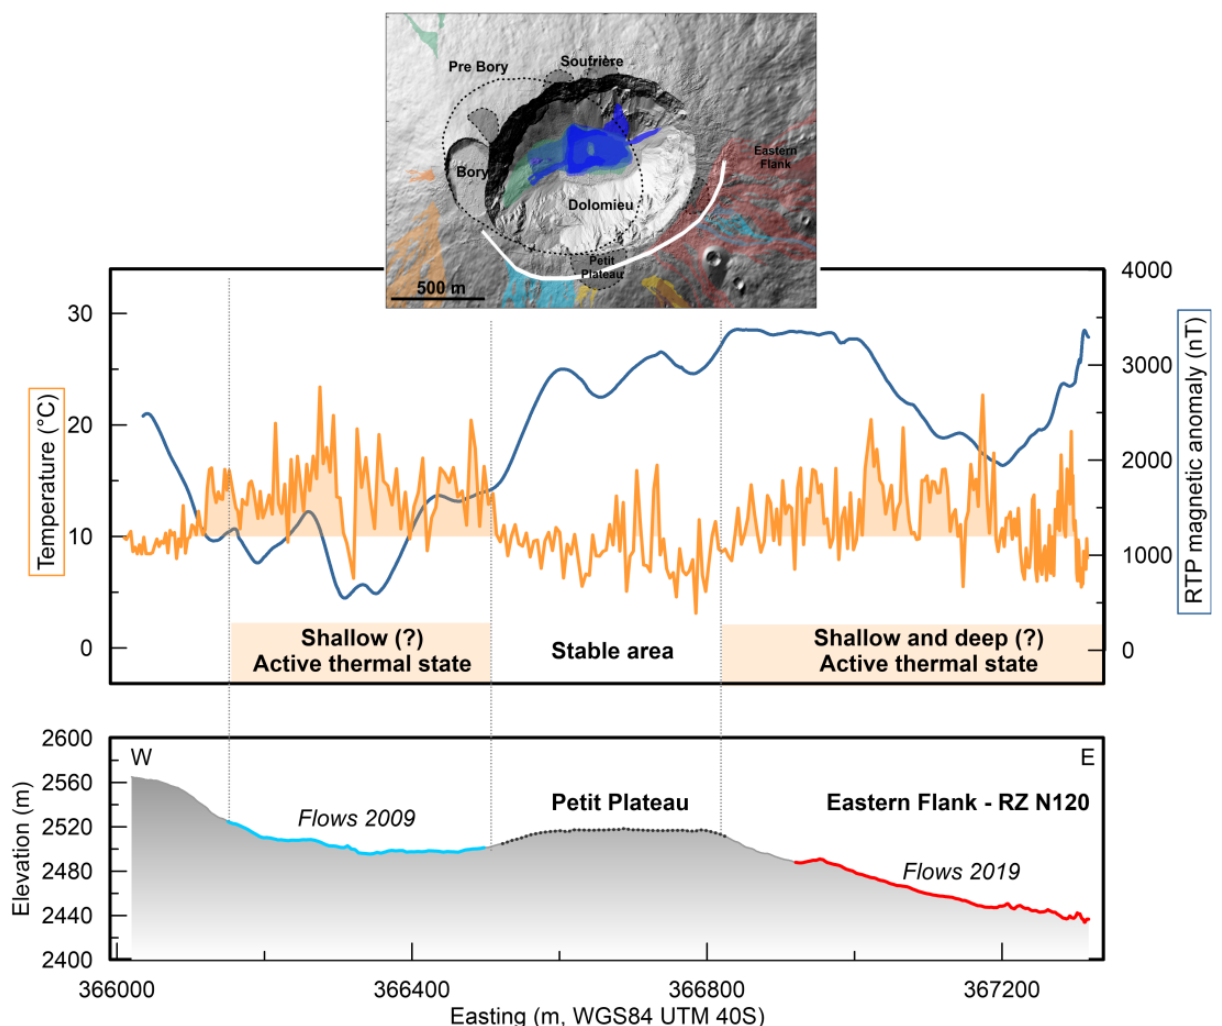
Figure 5: Detailed comparison between IR temperature and magnetic anomalies along a main profile, to the south of the Dolomieu crater (located in white on top ; the color code for the lava flows is the same as in Figure 1), highlighting the main thermally active and stable areas.